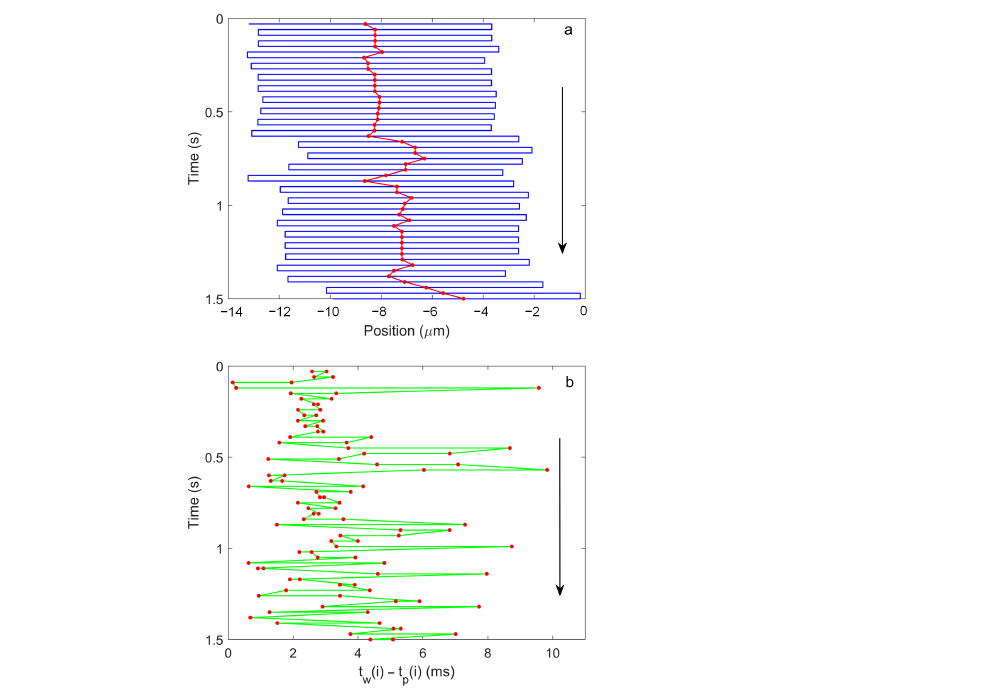
Figure 7. ( a ) Blue solid line is the trajectory of the piezo stage, the red dot is then center of the